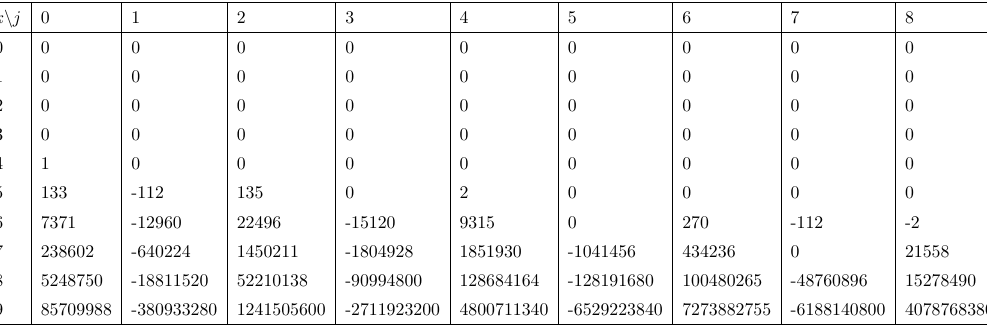
Table 87. Table of b jk coe(cid:14)cients for h E 7